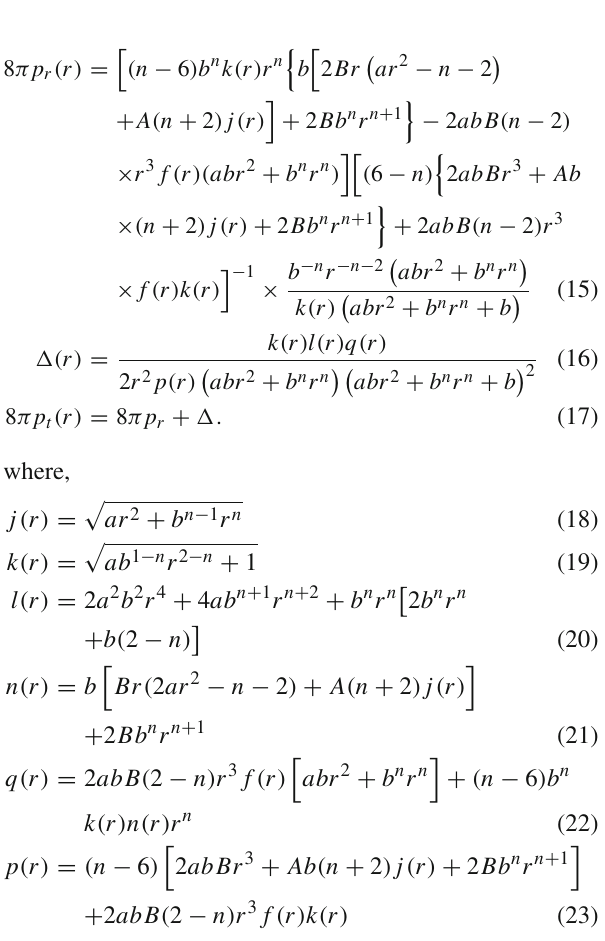
Fig. 4 Anisotropy profile of PSR J1614-2230 for M = 1 . 97 M (cid:6) , R = 9 . 69 km and b = 0 .